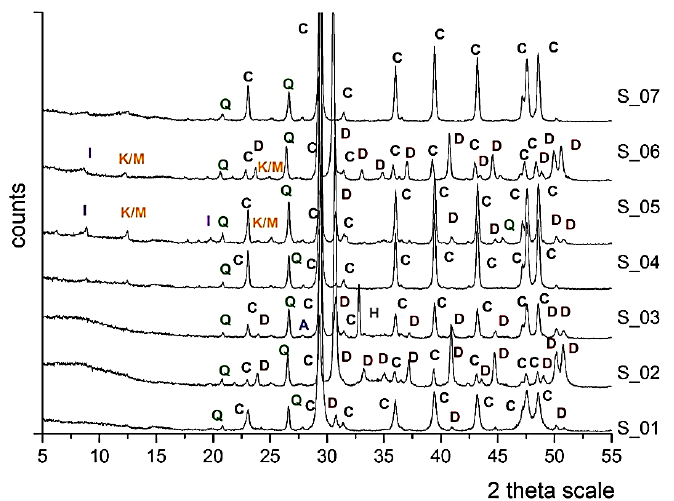
Figure 4. Quantification of halite crystallization events on seasonal basis using Athens-Hellinikon HNMS station data, in the period 1980 – 2004. Black squares indicate winter (DJF) values, green circles spring (MAM), grey triangles summer (JJA) and red diamonds autumn (SON).